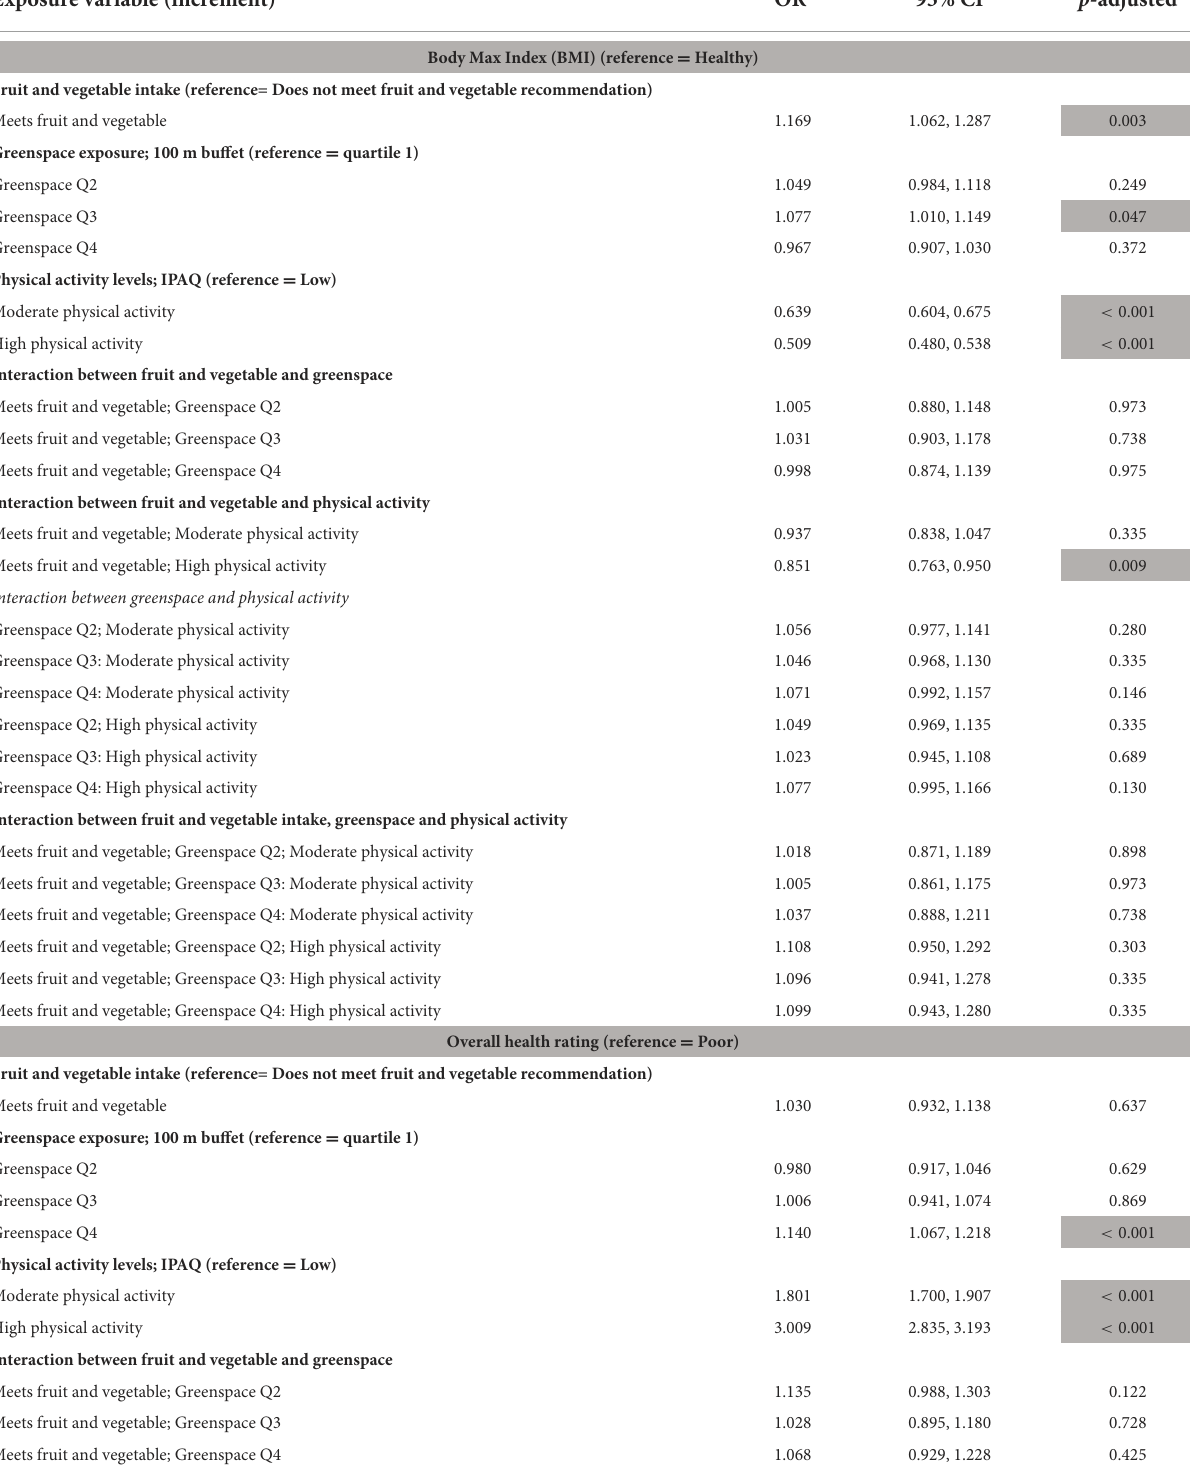
TABLE 1 Odds Ratio (OR) with 95% bootstrap confidence intervals (bCIs), and Benjamini & Hochberg adjusted p -value of greenspace exposure at a 100 m buffer [GE; reference = (Greenspace Q 1)], physical activity levels (IPAQ; reference = Low), fruits and vegetables intake (FyV; reference = < 5 portions), and the interactions between these variables for BMI (reference = Healthy), overall health rating (reference = Poor), blood pressure (reference = Healthy), loneliness (reference = No). Exposure variable (increment) OR 95%